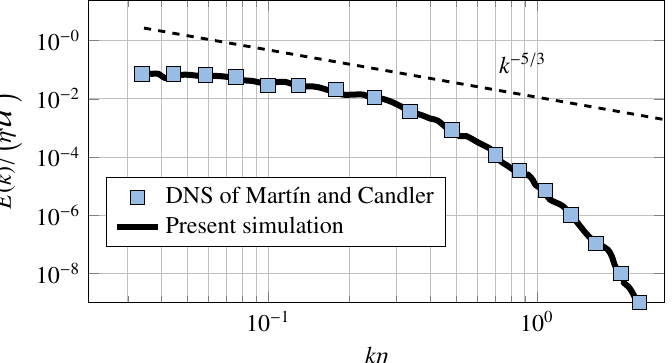
Figure 1. Energy spectrum at t / τ t = 6.5. The dashed line represents the k − 5/3 slope.